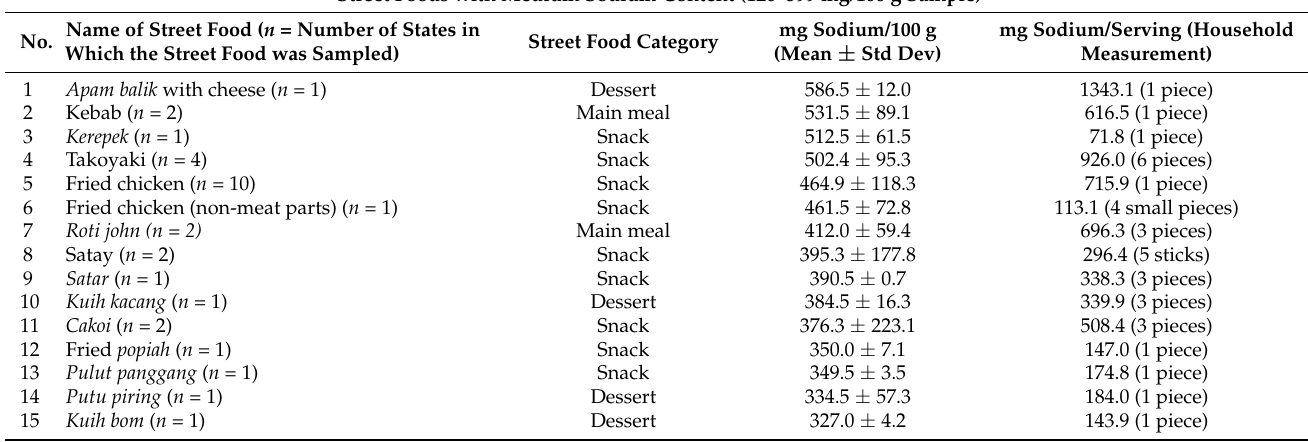
Table 5. Other street foods with medium (120–599 mg/100 g sample) and low (<120 mg/100 g sample) sodium